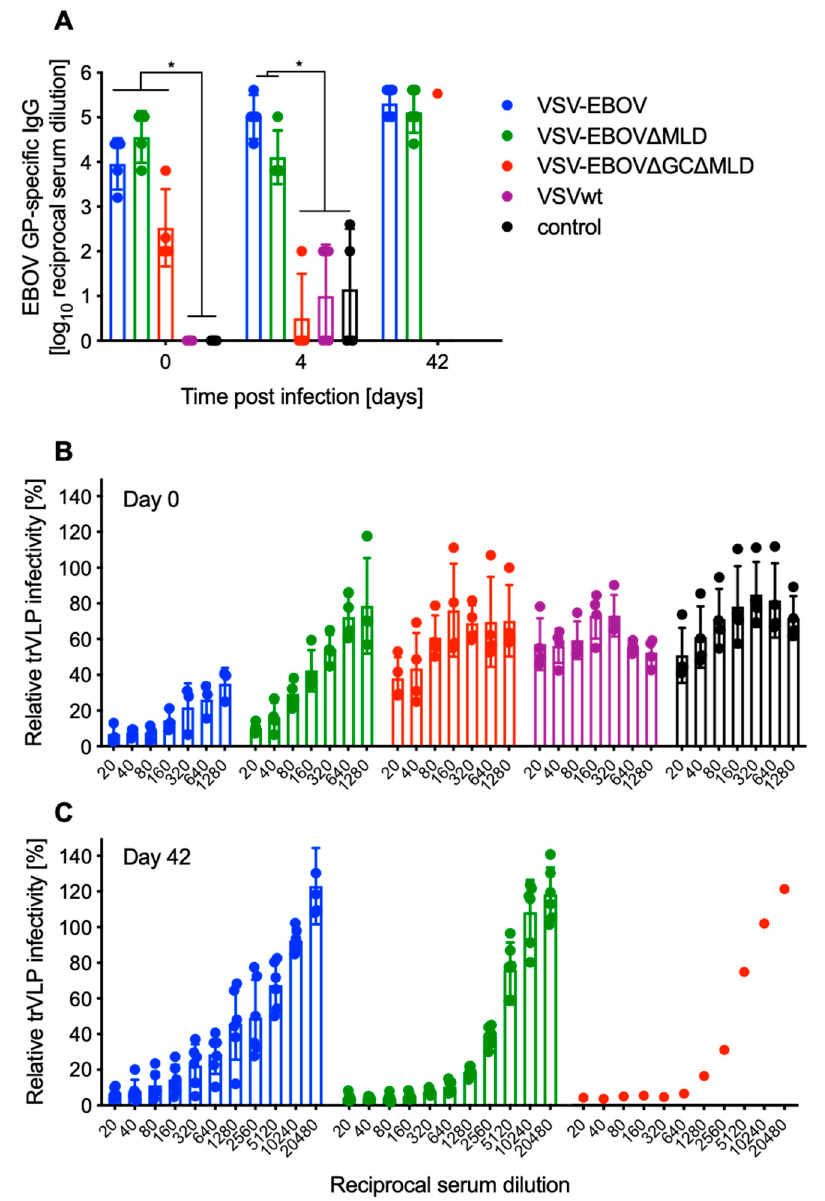
Figure 3. Humoral immune responses in vaccinated and challenged mice. ( A ) EBOV GP-specific IgG was assessed in serum samples from mice on day 0 ( n = 4; 28 days after vaccination), day 4 ( n = 4) and day 42 (all survivors). Geometric mean and SD are depicted. Statistical significance is indicated, p < 0.05 (*). ( B ) Neutralizing activity in the serum of vaccinated mice (day 0, n = 4 per group) and ( C ) challenge survivors (day 42; n = 6 for VSV-EBOV and VSV-EBOV ∆ MLD or n = 1 for VSV-EBOV ∆ GC ∆ MLD) was determined using the EBOV trVLP system expressing eGFP. Mean and SD are depicted.